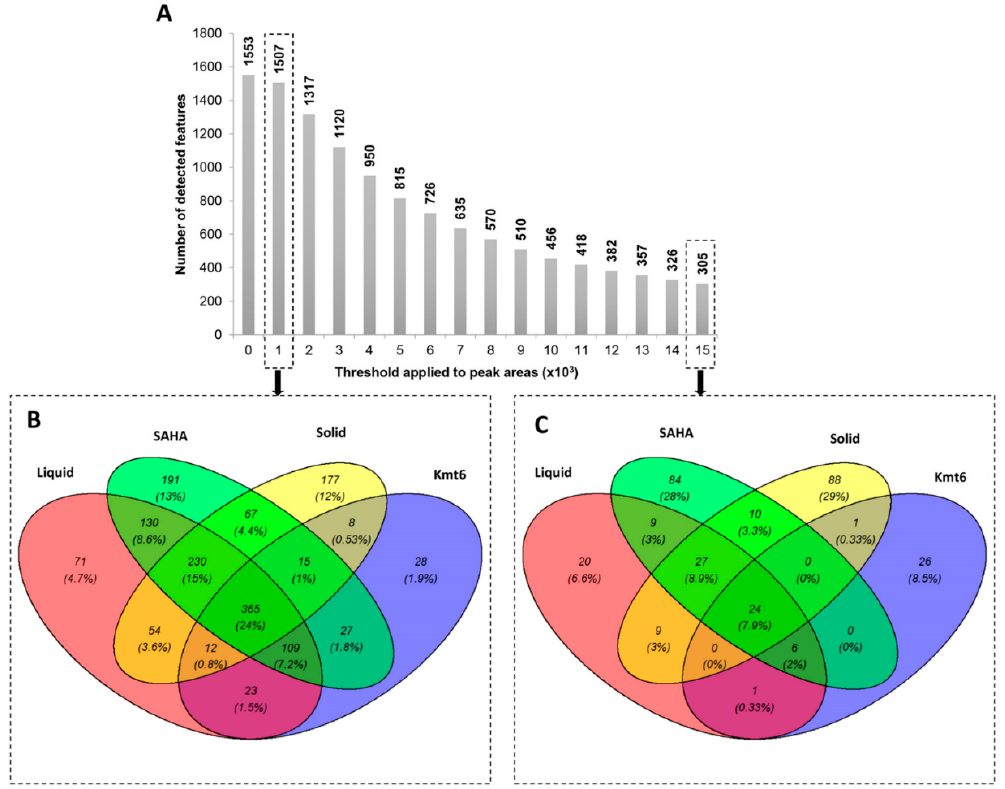
Figure 1. Representation of overlapping features from the different conditions tested for SM pro- duction in P. anserina after 8 days of culture. ( A ) Variation of the number of features considered with the threshold on peak areas applied with ( B ) and ( C ) corresponding to the Venn diagrams obtained with the intensity thresholds set to 1000 and 15,000 a.u., respectively. “Liquid”: M2 liquid medium inoculated with WT; “Solid”: M2 solid medium inoculated with WT; “SAHA”: M2 liquid medium supplemented with 100 µ M SAHA and inoculated with WT; “Kmt6”: M2 liquid medium inoculated with the Kmt6 mutant strain. All the experiments were performed in quadruplicates, except for the condition “Liquid” for which 8 replicates were